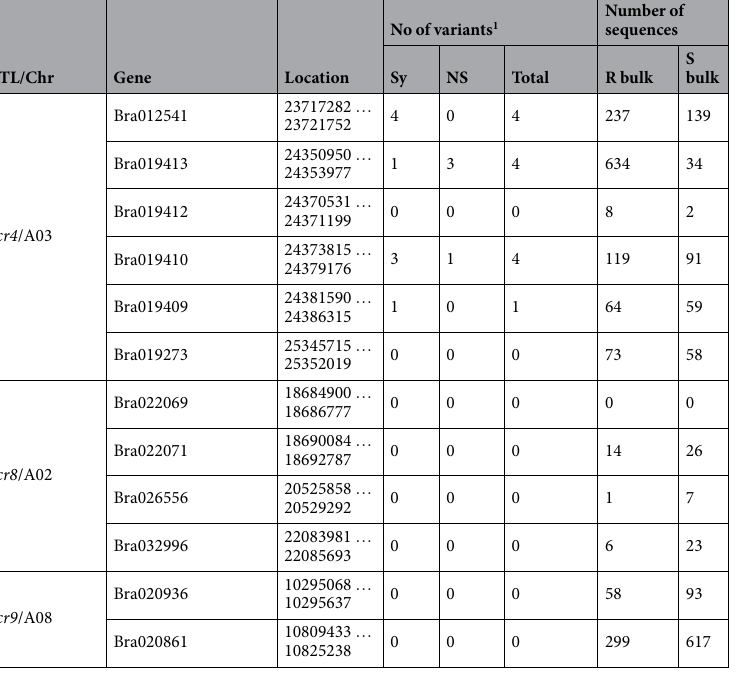
Table 4. Number of variants identified in TNL genes in the target regions. 1 SeqMan Pro software was used to sort variants that affect amino acid sequences into four groups: non-synonymous (NS), nonsense, frameshift and synonymous (Sy) variants. However, nonsense and frameshift variants were not found in all of the TNL genes in this